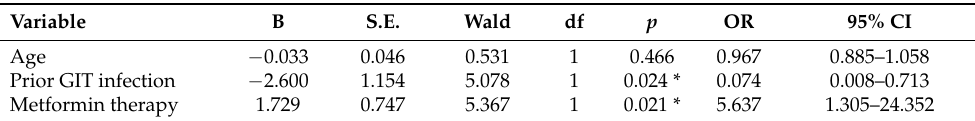
Table 3. A predictive model for good GBS outcome in diabetic